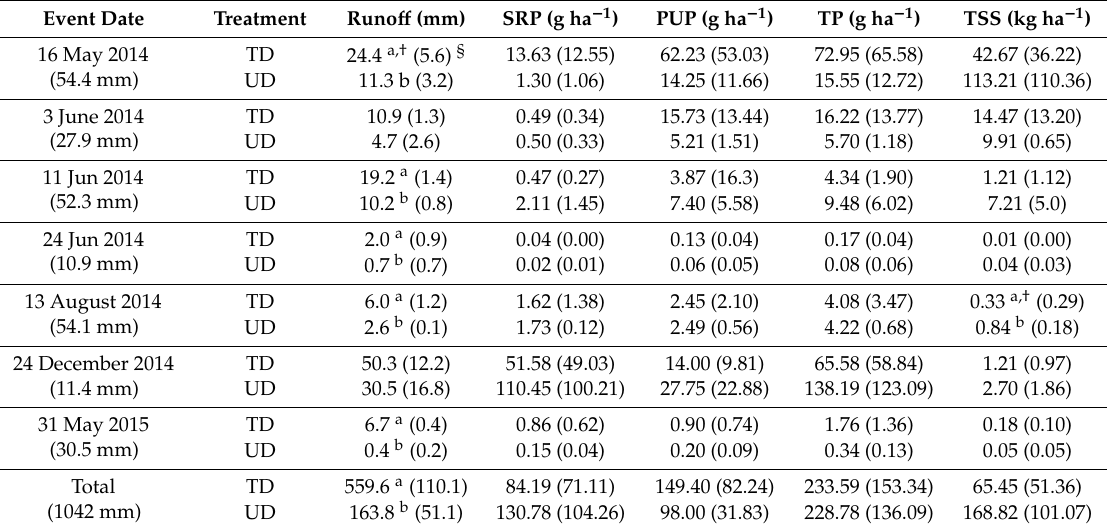
† Means with di ff erent letters are di ff erent at p ≤ 0.10. § Values in parentheses are standard